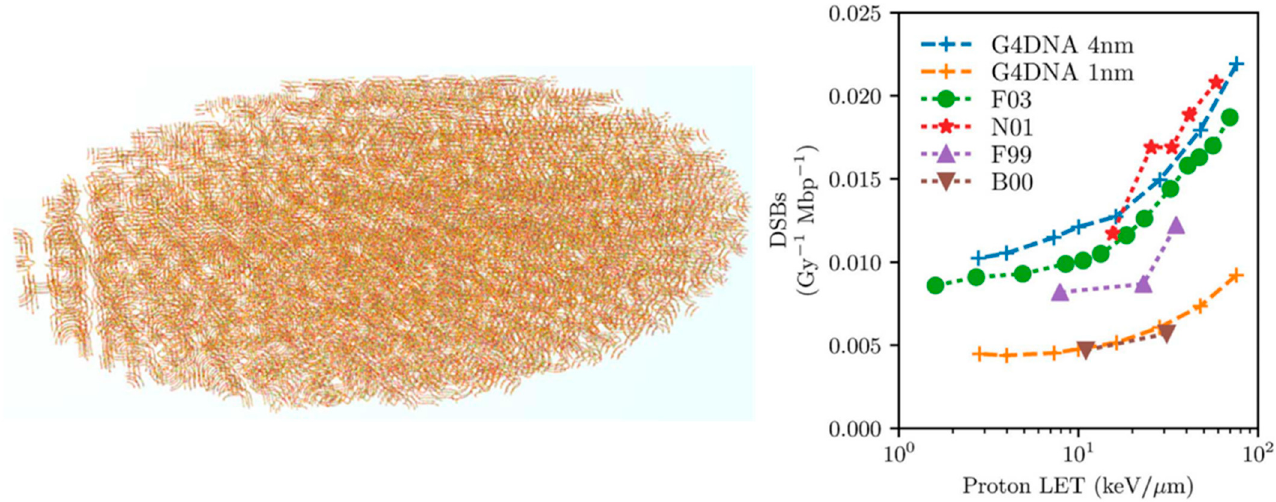
Figure 6. Left: E. coli geometry that was generated by the molecularDNA application. Right: the DSB yields as a function of LET from proton irradiation assessed by Geant4-DNA, compared to the results of PARTRAC (F03) and KURBUC (N01), and experimental data (F99, B00). Taken from Lampe et al. [71].